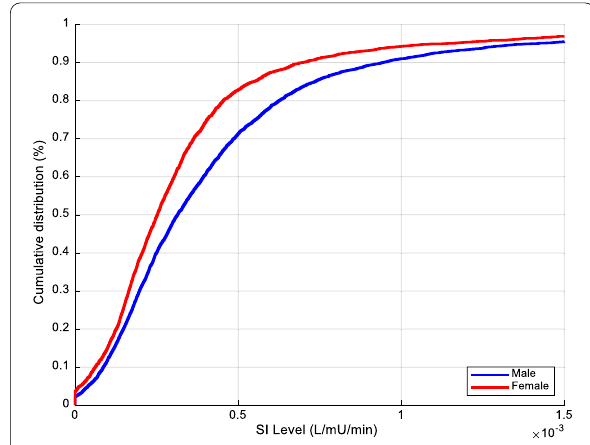
Fig. 2 Overall cumulative SI levels (L/mU/min) between male and female cohorts